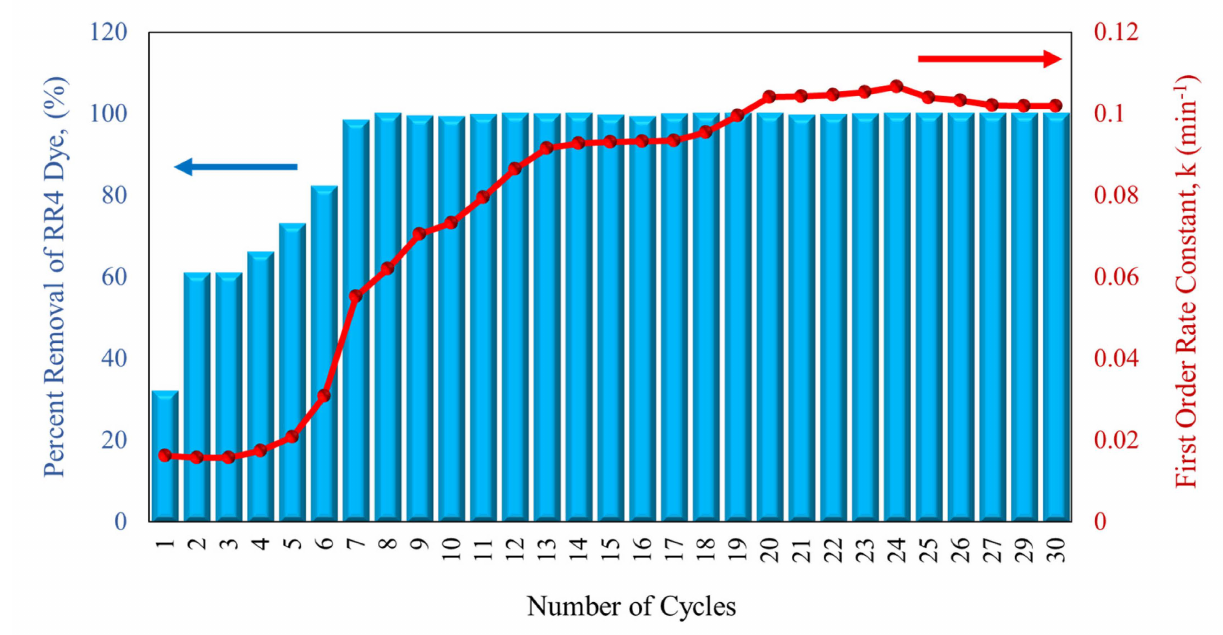
Figure 12. Pseudo first-order rate constant (min − 1 ) and percent removal of RR4 dye (%) vs. number of photocatalysis cycles using the TEP24